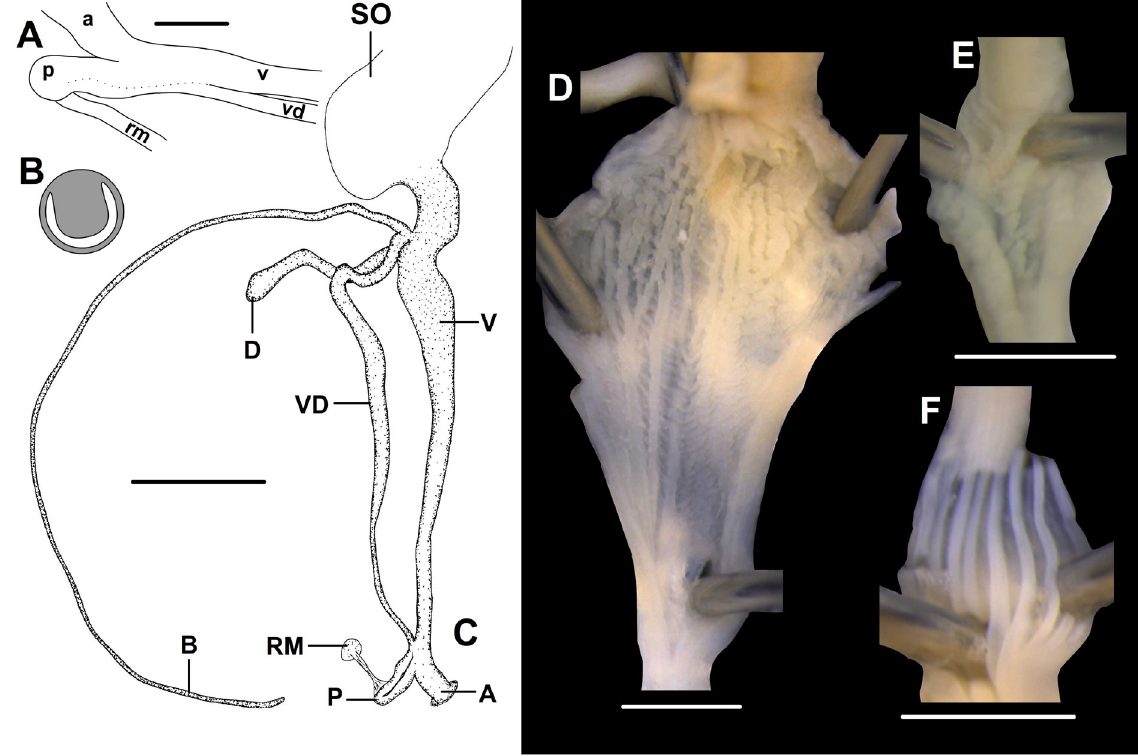
Fig. 27. Genitalia of Chersaecia scabra sp. nov. (NHMUK 20170149). A . Male genitalia. B . Cross sectional diagram of the penis. C . Distal genitalia. D–F . Inner structure of genital organs (D = vagina, E = vas deferens, F = diverticulum). Scale bars: A, D–F = 0.5 mm; C = 2 mm; B not to scale. For abbreviations see Fig. 2. All photos: B.